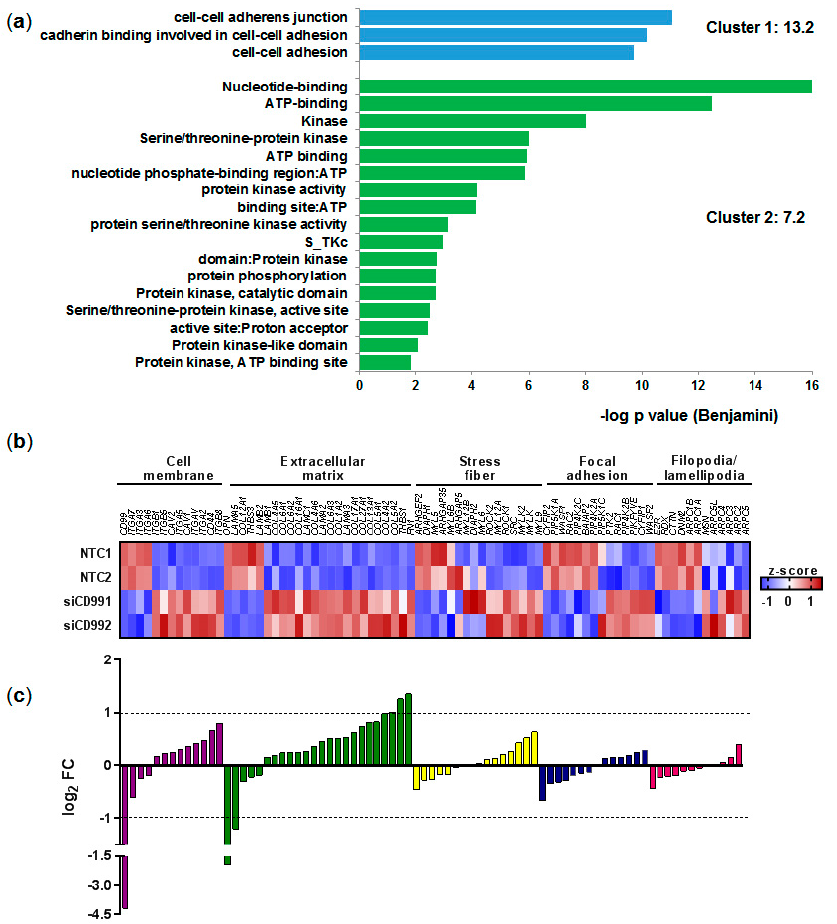
Figure 2. Transcriptome analysis of U87MG cell line knockdown for CD99 by siRNA. ( a ) The two most enriched functional annotation clusters by the DAVID annotation cluster analysis of differentially expressed genes after CD99 knock down (adjusted p ≤ 0.01). ( b ) Heatmap representing expression of genes coding for proteins of cell membrane, extracellular matrix, stress fiber, focal adhesion and filopodia/lamellipodia. RPKM values of experimental duplicates were normalized by z-score ( c ) The log 2 fold-change (FC) of genes represented in the heatmap.